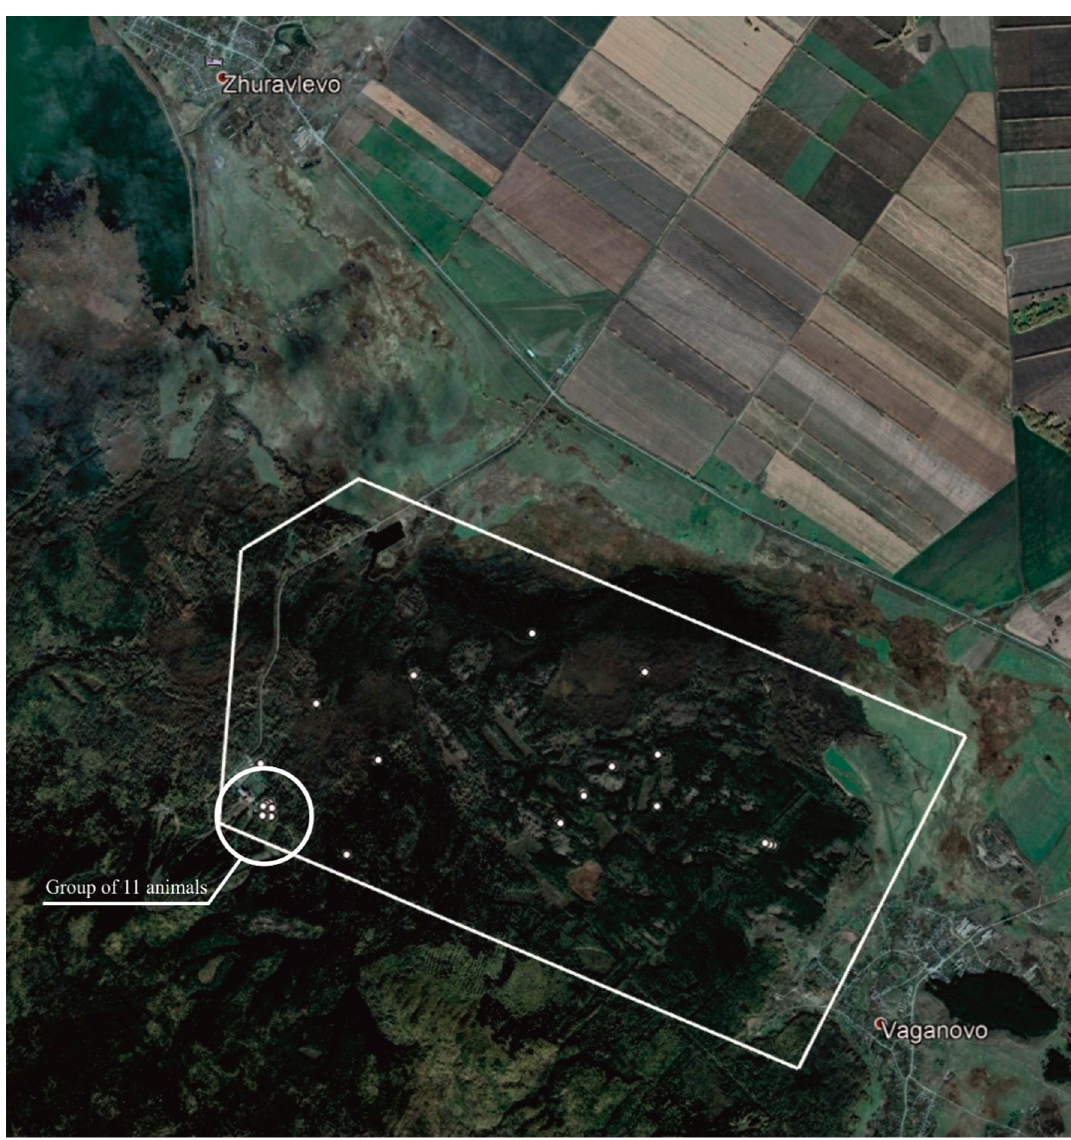
Figure 3. Map of the elk population in the area surveyed in 2019. A cluster of animals was detected on the territory of the rehabilitation center of the Tanay ski resort. on the territory of the rehabilitation center of the Tanay ski